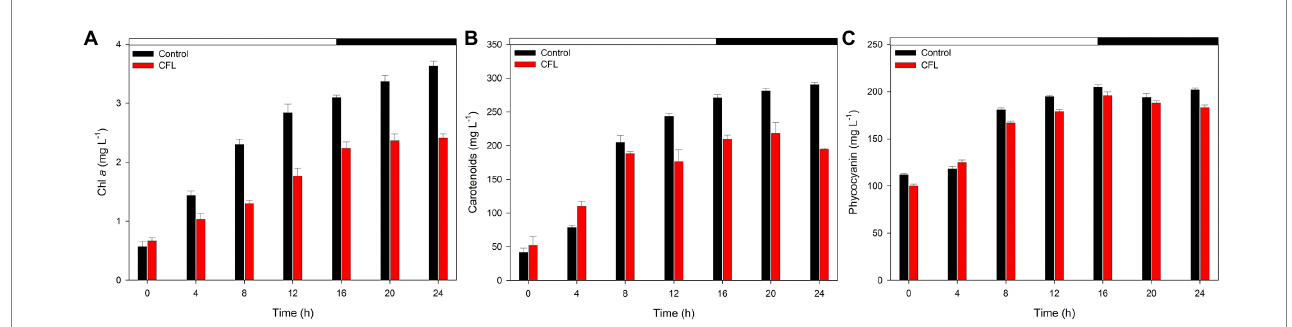
FIGURE 2 Photosynthetic pigments in synchronous control (black bar) and CFL–treated (red bar) Galdieria sulphuraria cultures, expressed as mg L − 1 (A) chlorophyll a , (B) carotenoids, (C) phycocyanin. The dark phase is indicated by the black bar above the graph. The data are plotted as means of biological triplicates. The error bars represent standard deviations (±SD). For details of statistical analysis (multiple linear regression) see Supplementary Table